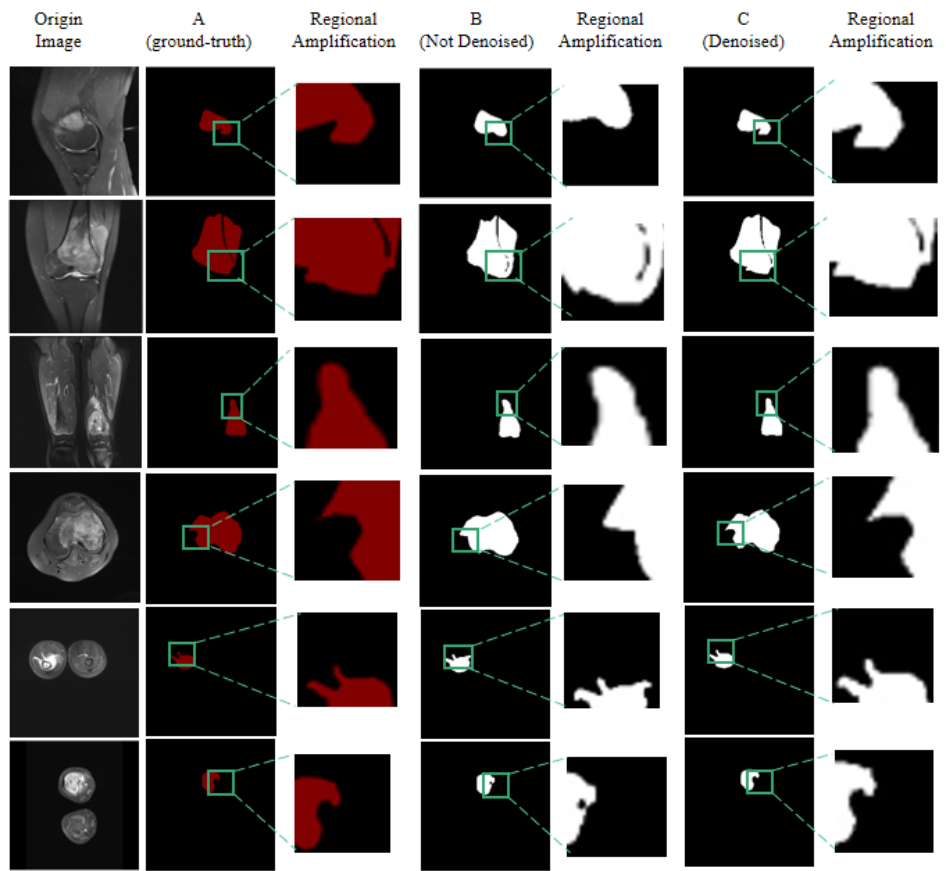
Figure 8. The segmentation effect before and after noise reduction. The sub-figure ( A ) represents the ground truth of the image, the sub-figure ( B ) represents the result of image segmentation without Denoised, and the sub-figure ( C ) represents the result of image segmentation with Denoised.